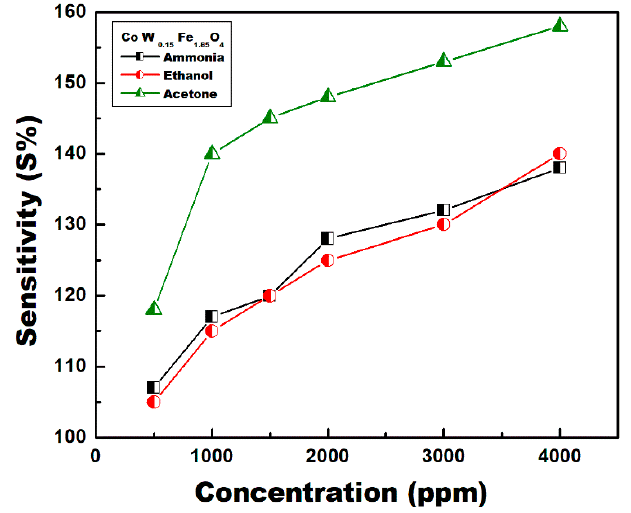
Figure 13. CoFe 2 O 4 -1.5%W sensors response (Res %) at different gas concentrations (ppm) and 200 °C.